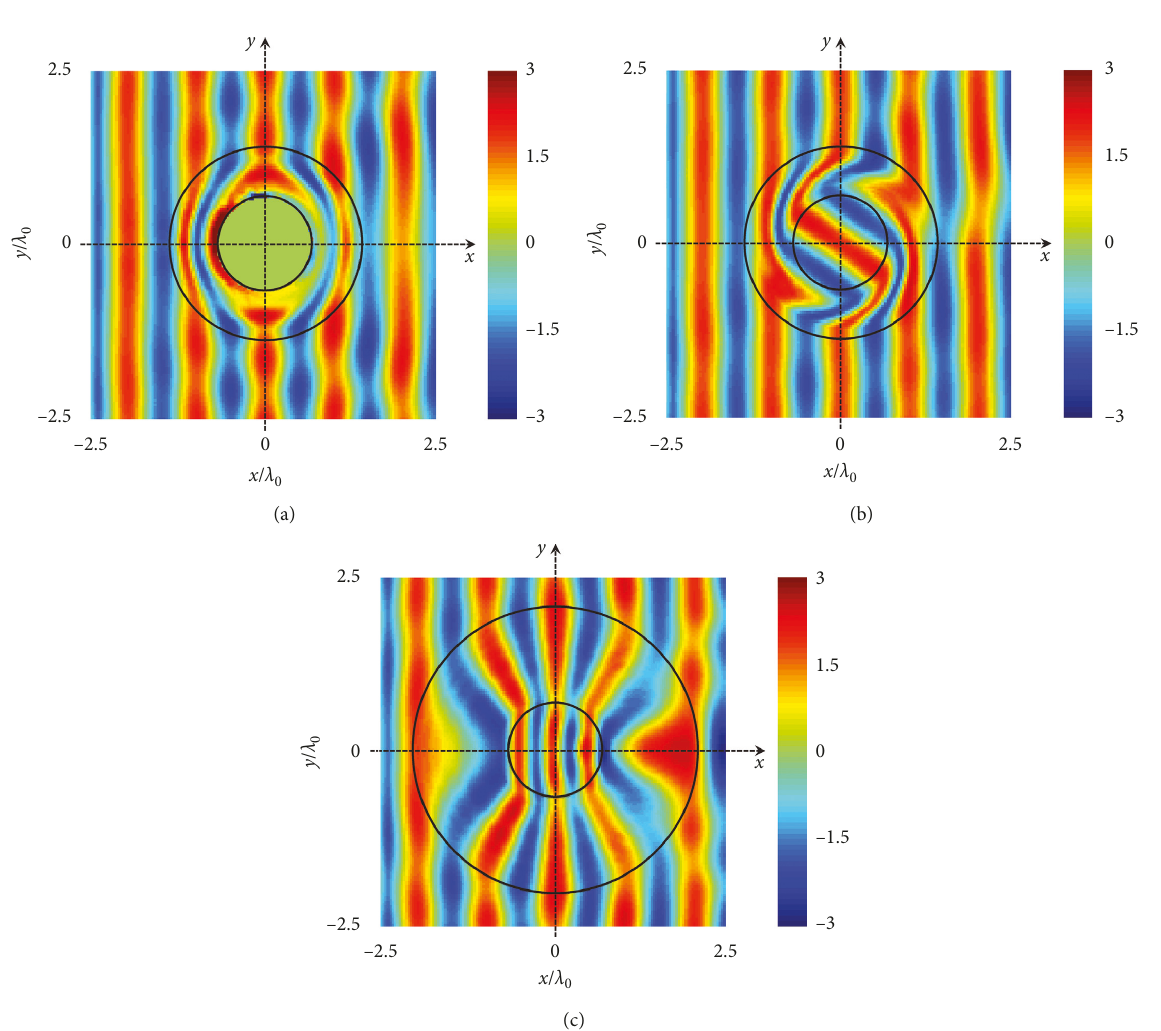
Figure 14: FDTD snapshots with boundary abrasion with the use of third-order functions: (a) the cloak, (b) the rotator, and (c) the concentrator. The functionalities of MTMs remained relatively